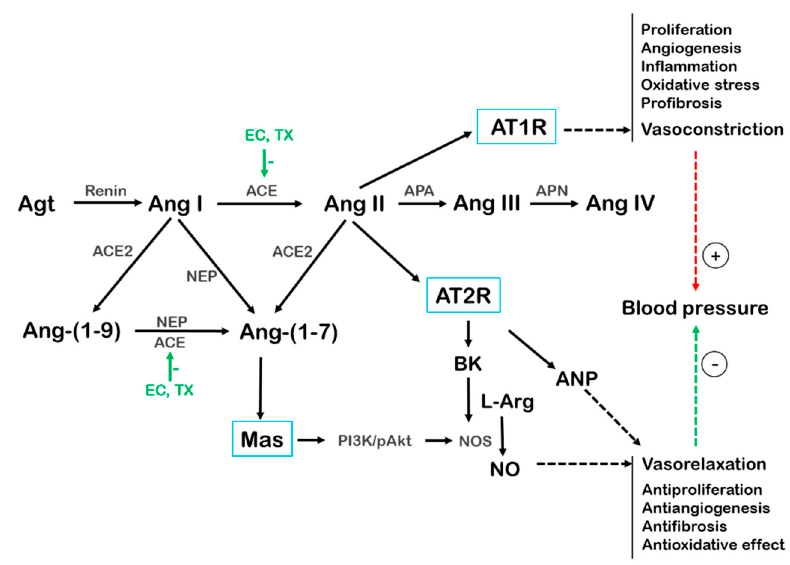
Figure 4. A brief, although not exhaustive, scheme of the renin–angiotensin system. Abbreviations: ACE, angiotensin converting enzyme; Agt, angiotensinogen; Ang, angiotensin; ANP, atrial natriuretic peptide; APA, aminopeptidase A; APN, aminopeptidase N; AT1R, angiotensin II type 1 receptor; AT2R, angiotensin II type 2 receptor; BK, bradykinin; EC, ( − )-epicatechin; L-Arg, L-arginine; Mas, Mas receptor; NEP, neutral endopeptidase, NO, nitric oxide; NOS, nitric oxide synthase; PI3/Akt, phosphatidylinositol 3-kinase/kinase B; TX, (+)-taxifolin, ( − )-taxifolin or their racemic mixture.